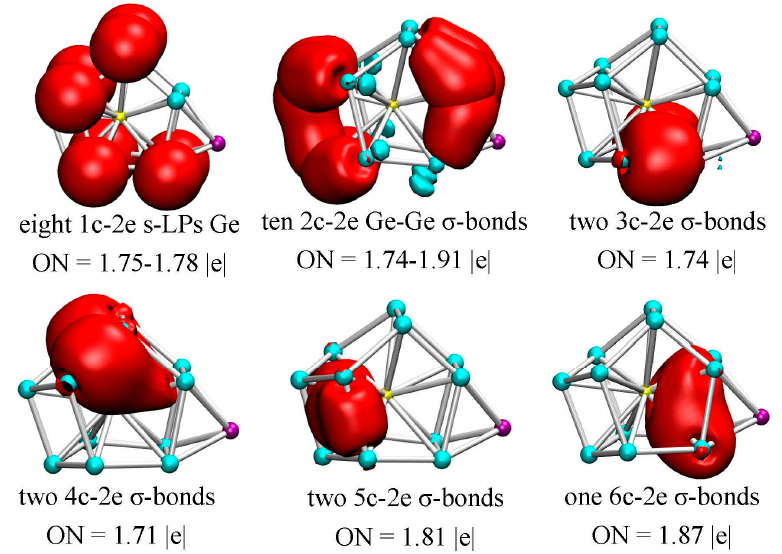
Figure 5. AdNDP chemical bonding analyses of the Li@Ge 12 Au (12 B ) cluster. ON denotes the electron occupation number and is close to the ideal population of 2.00 |e|.